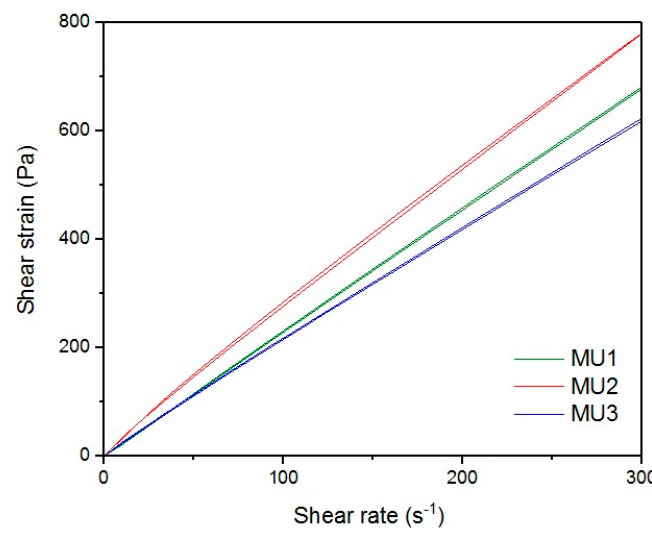
Figure 18. Magnification of the shear strain-shear rate relations for MU1–MU3 prepolymers at CSR = 300 s − 1 .